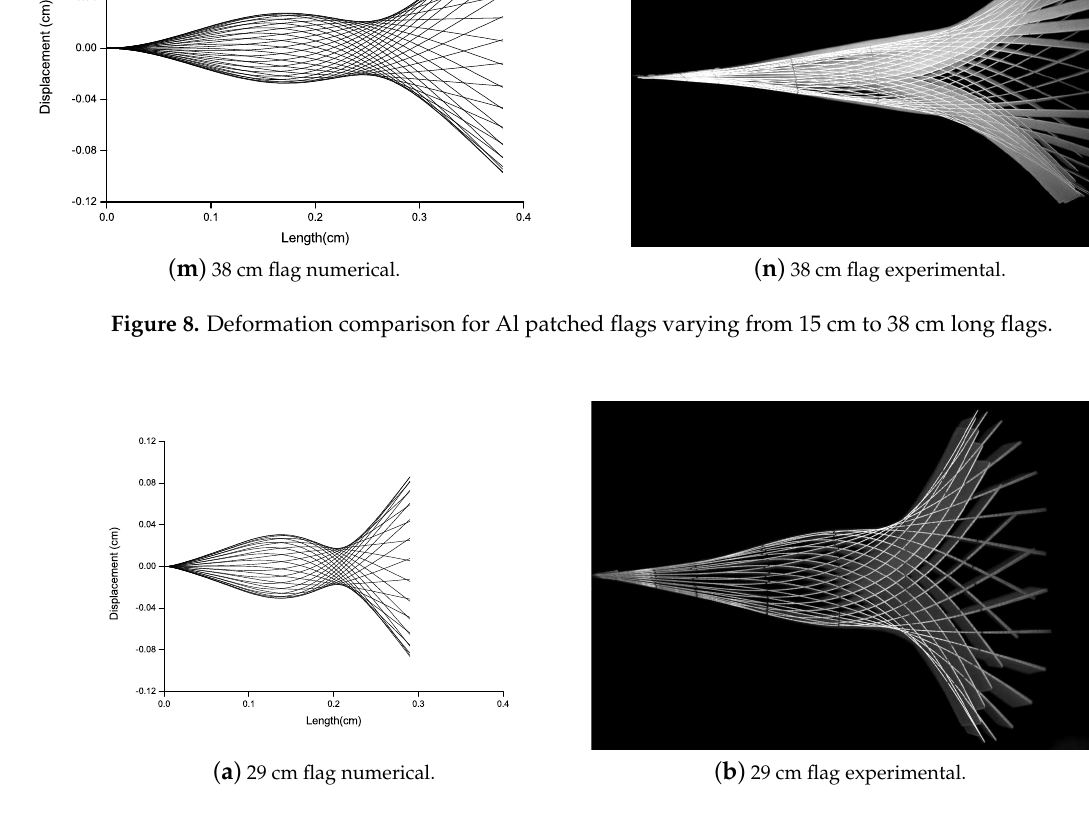
Figure 9. Deformation comparison for PZT patched